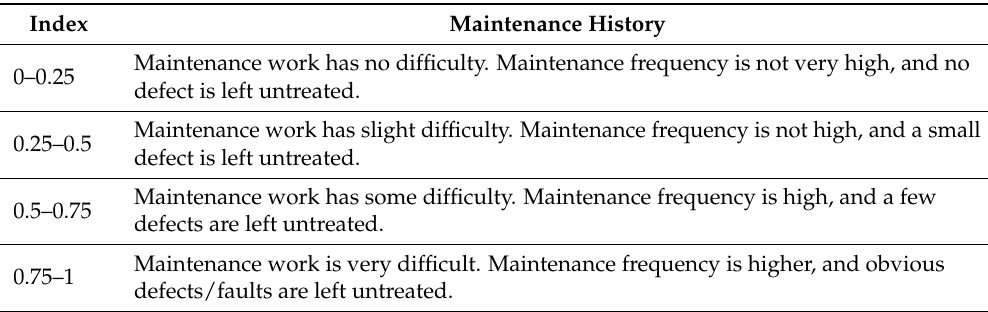
Table 2. Account of transformer maintenance